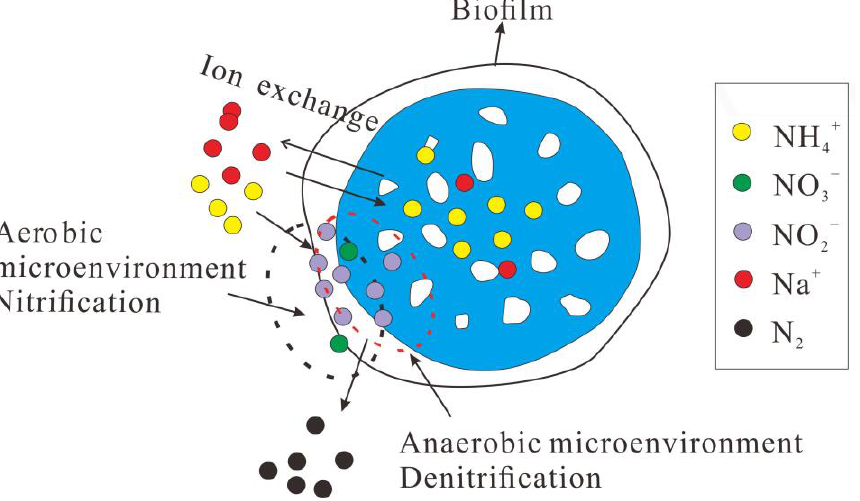
Figure 10. Mechanism of denitrogenating regeneration of the MBBR adsorption-shortcut SND.